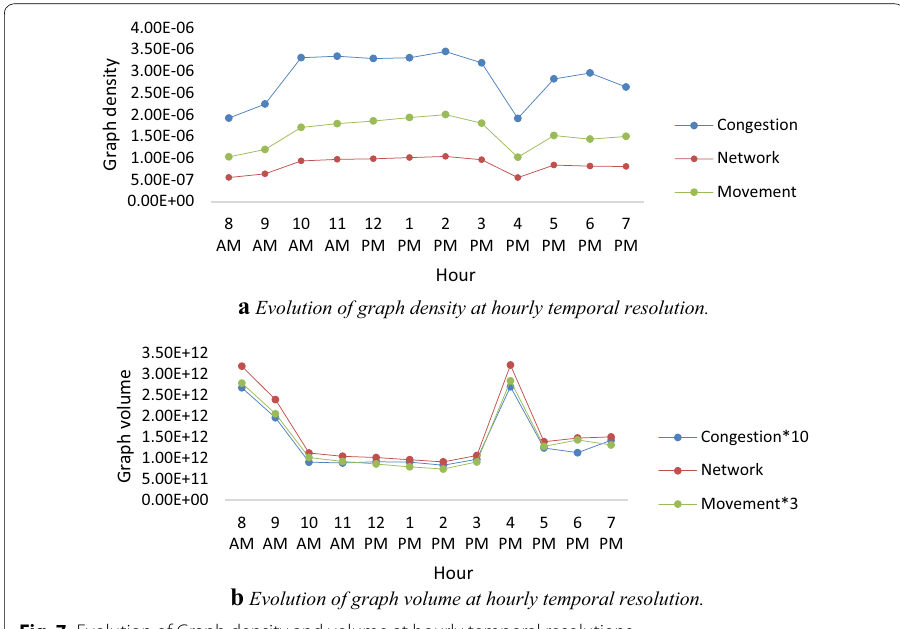
Fig. 7 Evolution of Graph density and volume at hourly temporal